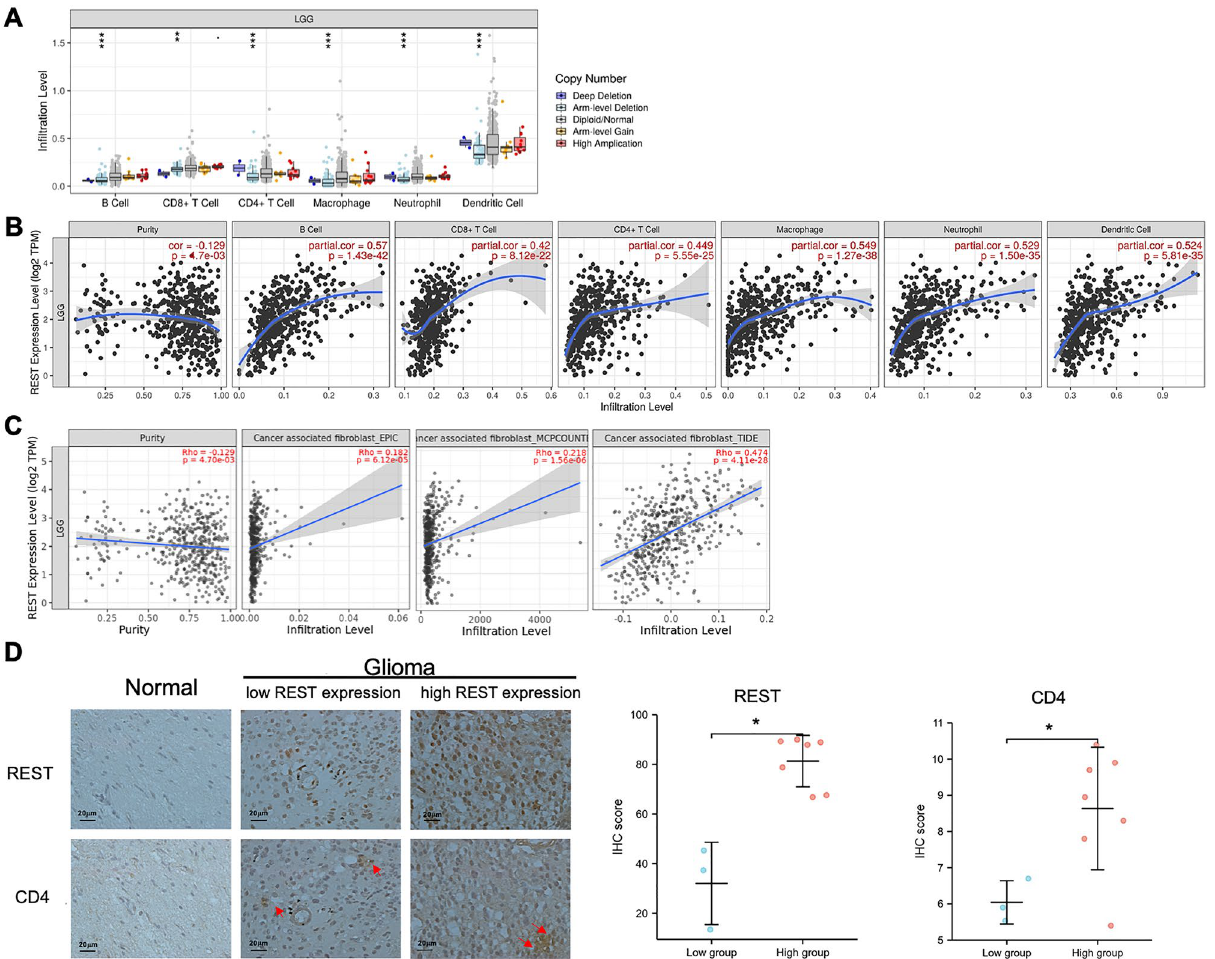
Figure 4. The correlation between REST and immune cell infiltration in glioma. ( A ) The infiltration level of various immune cells under different copy numbers of REST in glioma by TIMER2 (http:// timer. cistr ome. org/). ( B ) The correlation between REST expression level and infiltration level of immune cells in glioma by TIMER2 (http:// timer. cistr ome. org/). ( C ) The correlation between REST expression level and infiltration level of cancer- associated fibroblasts in glioma based on the EPIC, MCPCOUNTER and TIDE algorithms by TIMER2 (http:// timer. cistr ome. org/). ( D ) IHC staining (Olympus microscope) and the distribution of REST and CD4 IHC scores (H-SCORE, GraphPad Prism 9.3.1) in normal and glioma tissues by different REST expression. All data are shown as mean ± SD, * P value < 0.05; ** P value < 0.01; *** P value <